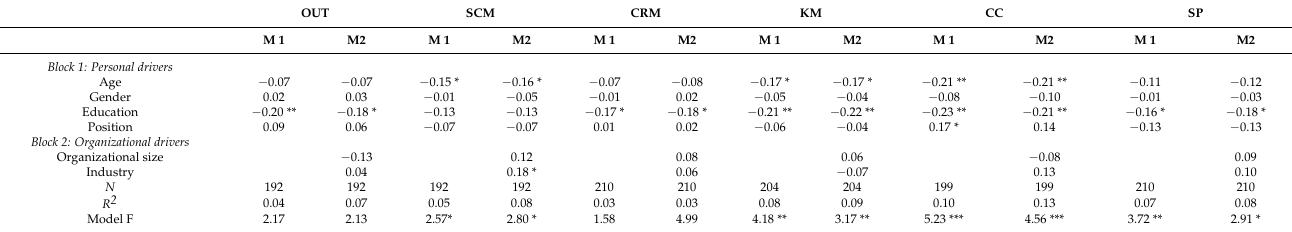
Table 4. Hierarchical regression results a